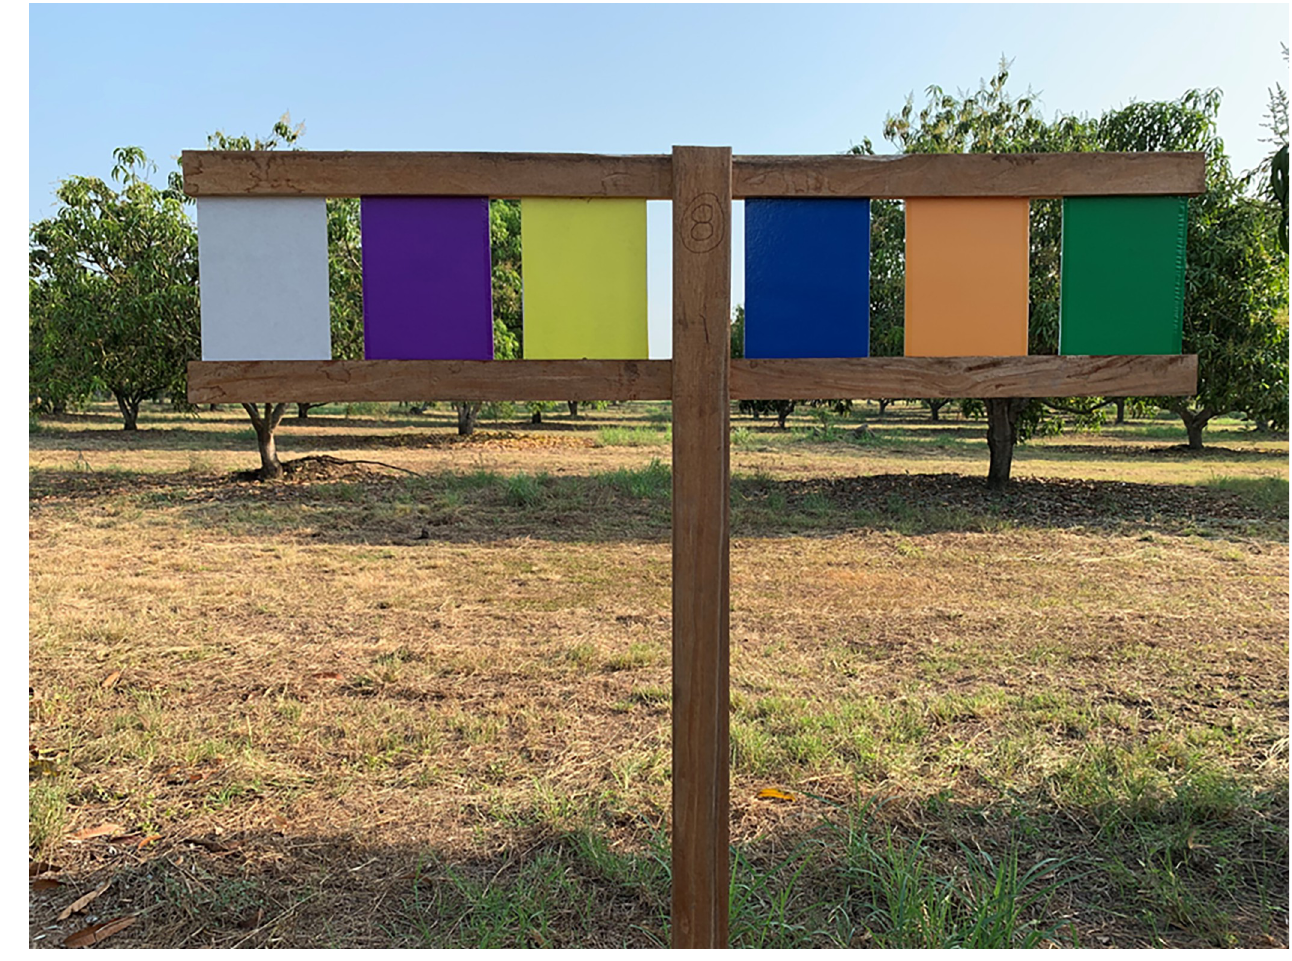
Fig 1. The colored sticky traps. Manner in which colored sticky traps were disposed in the mango orchard to attract thrips and other insects.